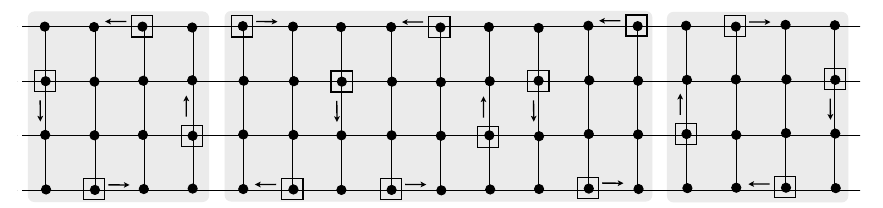
Figure 4: Guard configuration for n